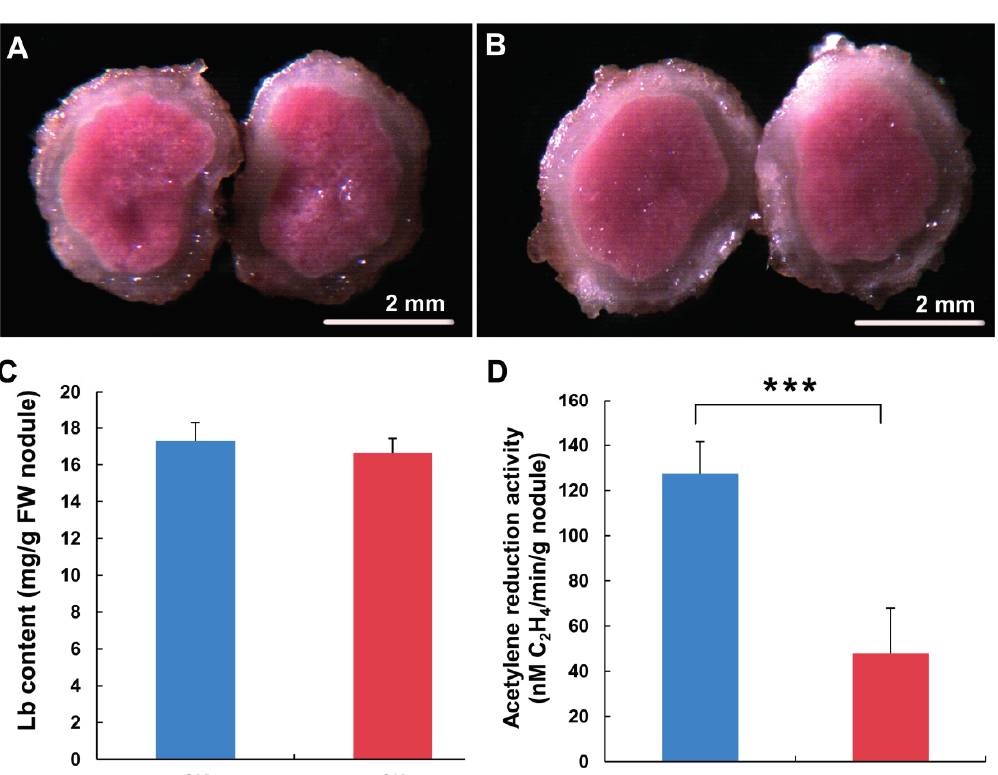
Figure 1. The nitrogen use efficiency of nitrogen-fixing nodules in soybean was affected by low temperature treatment. Seeds of Williams 82 were sown into a mixture of vermiculite and perlite and irrigated with a low nitrogen solution. Twenty-eight days after inoculation with Bradyrhizobium japonicum , the plants were dipped and washed with phosphate-buffered saline and then transferred to a low nitrogen solution without (CK) or with cold treatment (CH) at 4 °C for 24 h. The nodules were then collected and used for a phenotypic analysis and measurements of the leghemoglobin (Lb) content and acetylene reduction activity (ARA). Cross-sections of untreated and cold-treated nodules are shown in ( A , B ), respectively. Bars: 2 mm; The measured Lb contents and ARA levels are shown in ( C , D ), respectively. Student’s t -tests were performed; statistically significant results are marked with *** ( p <